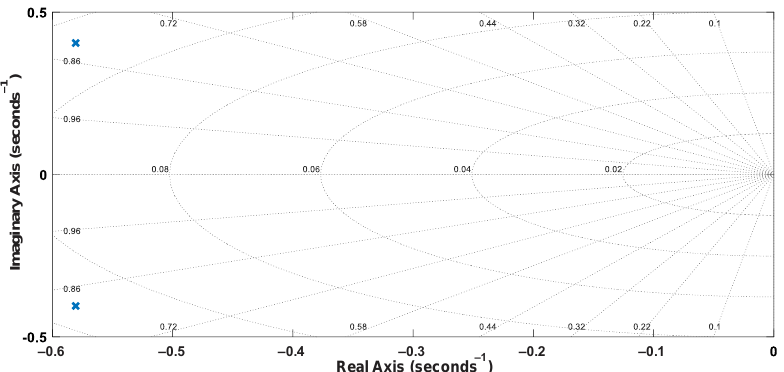
Figure 7. Step response of the plant models.